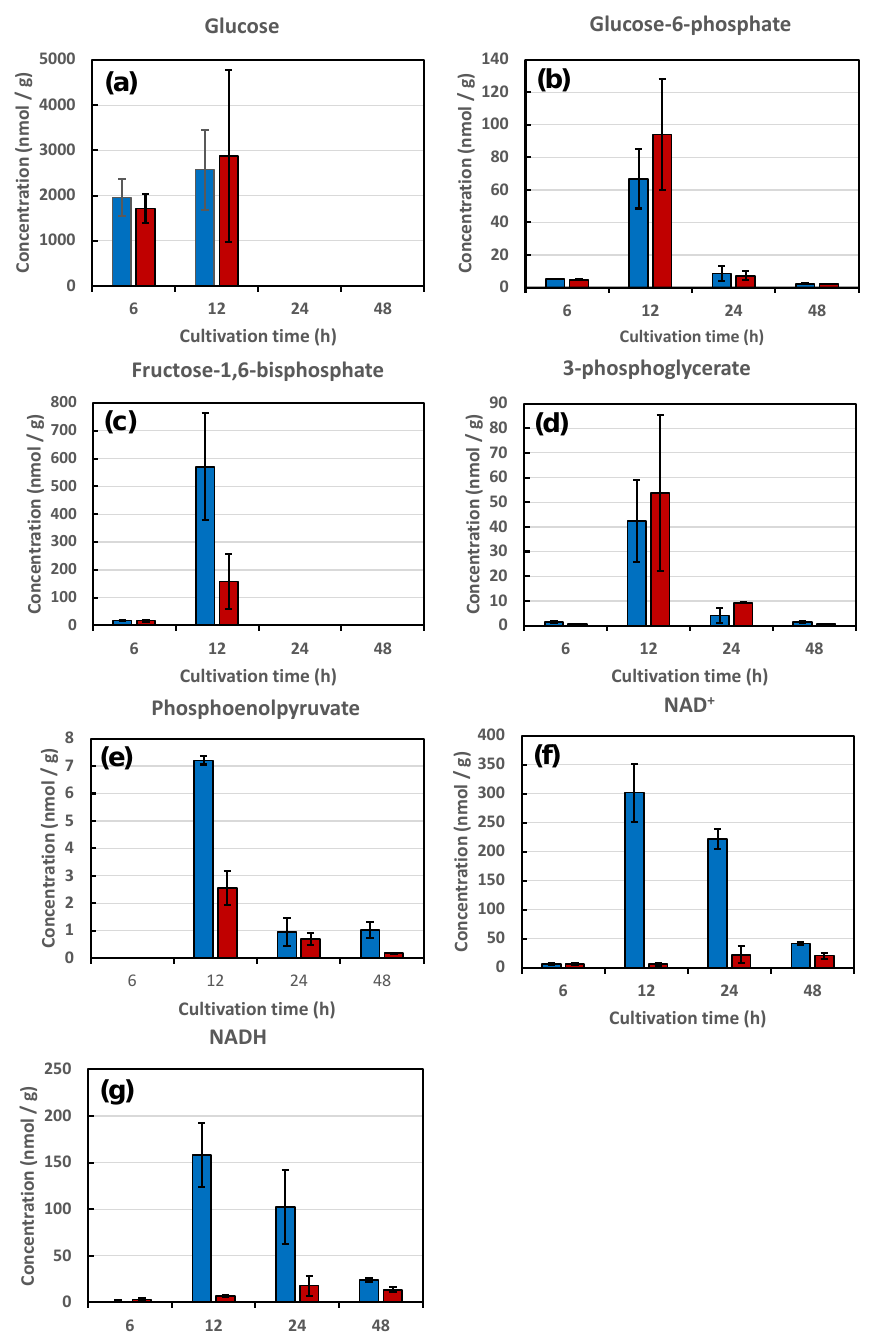
Figure 4. The concentrations of metabolites related to the glycolysis in strains KA31a (open bars) and a924E1 (closed bars) at 6 to 48 h of cultivation. The concentration of each metabolite is shown as nmol of metabolite per gram of dry weight of yeast cells. Panels ( a – g ) show the concentrations of glucose, glucose-6-phosphate, fructose-1,6-bisphosphate, 3-phosphoglycerate, phosphoenolpyruvate, NAD + , and NADH, respectively. Values are presented as mean ± standard deviation from three independent experiments.